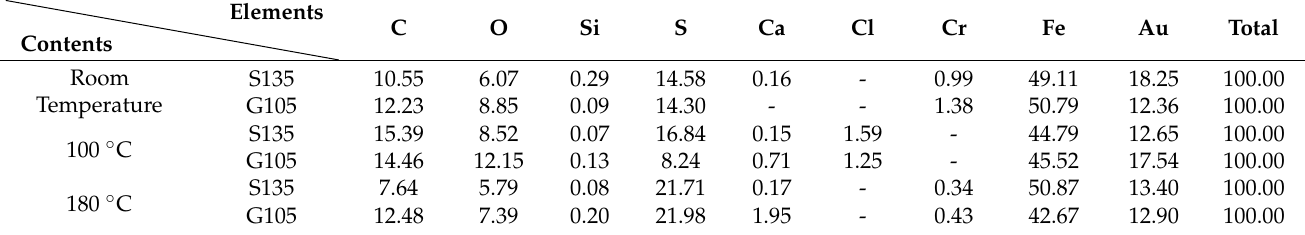
Figure 7. SEM images of S135 and G105 (after removing the corrosion products) at different temperatures: ( a ) S135, room temperature; ( b ) G105, room temperature; ( c ) S135, 100 ◦ C; ( d ) G105, 100 ◦ C; ( e ) S135, 180 ◦ C; ( f ) G105, 100 ◦ C. Table 4. Elemental composition of corrosion products according to energy spectra of S135 and G105 at room temperature